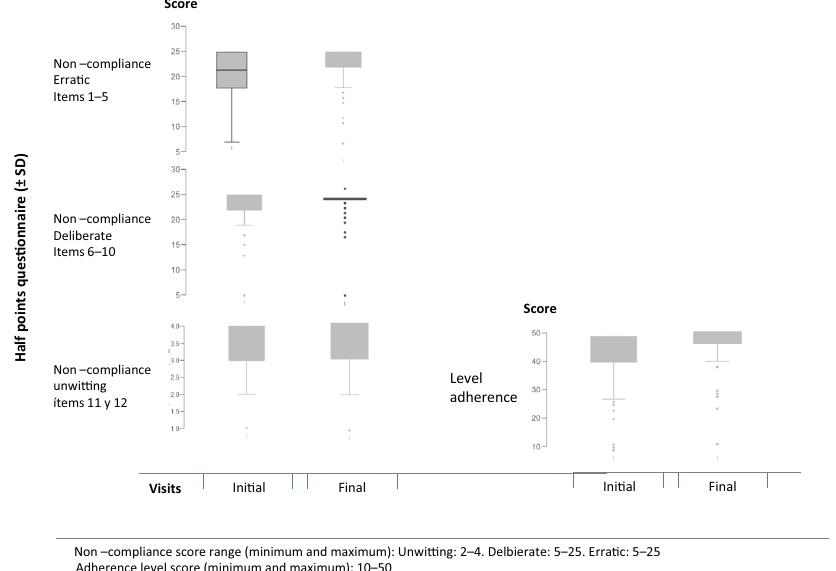
Fig. 5 Average scores (±SD) were obtained by the patients according to the established ranges to classify the type of noncompliance and the level of Adherence.